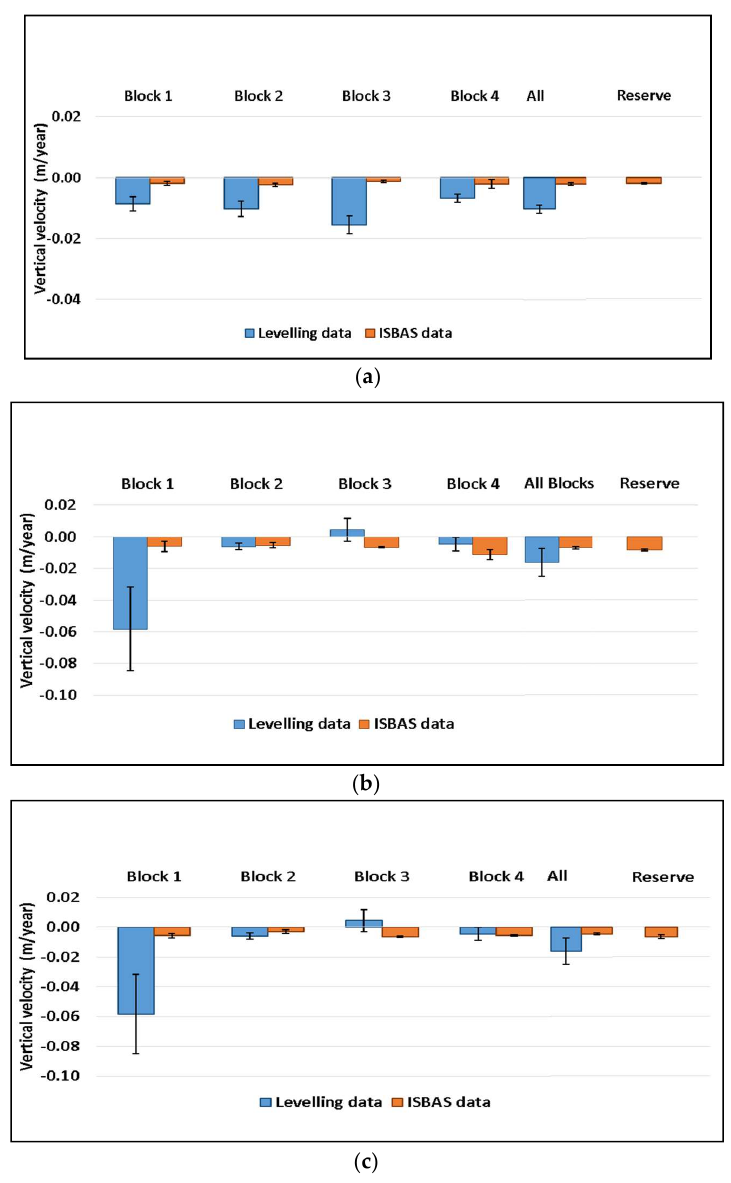
uplift during this period.